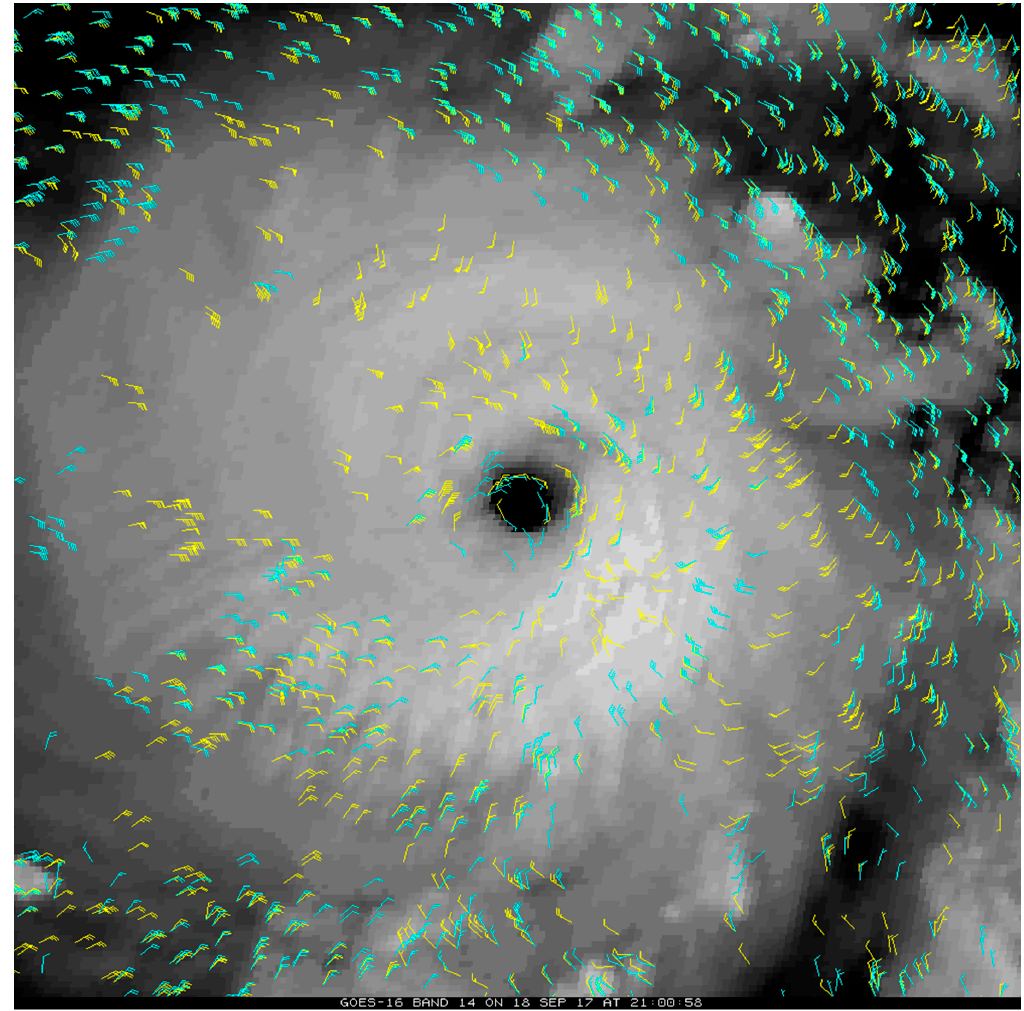
Figure 4. Same as Figure 3, except those yellow AMVs are now plotted in cyan. The yellow AMVs here are those added from reducing the image triplet time interval to 1 min sampling.